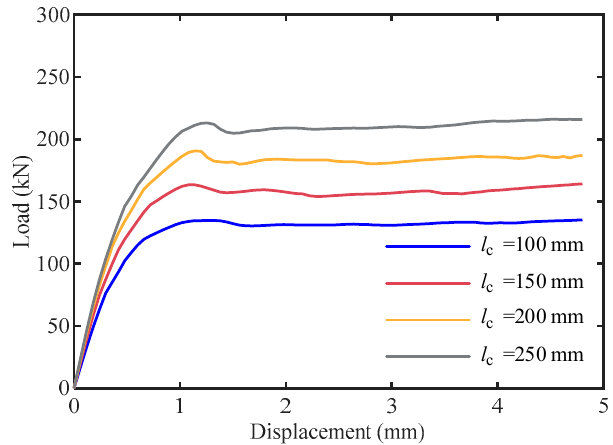
Figure 17. Influence of the length of the T ‐ stub connector.